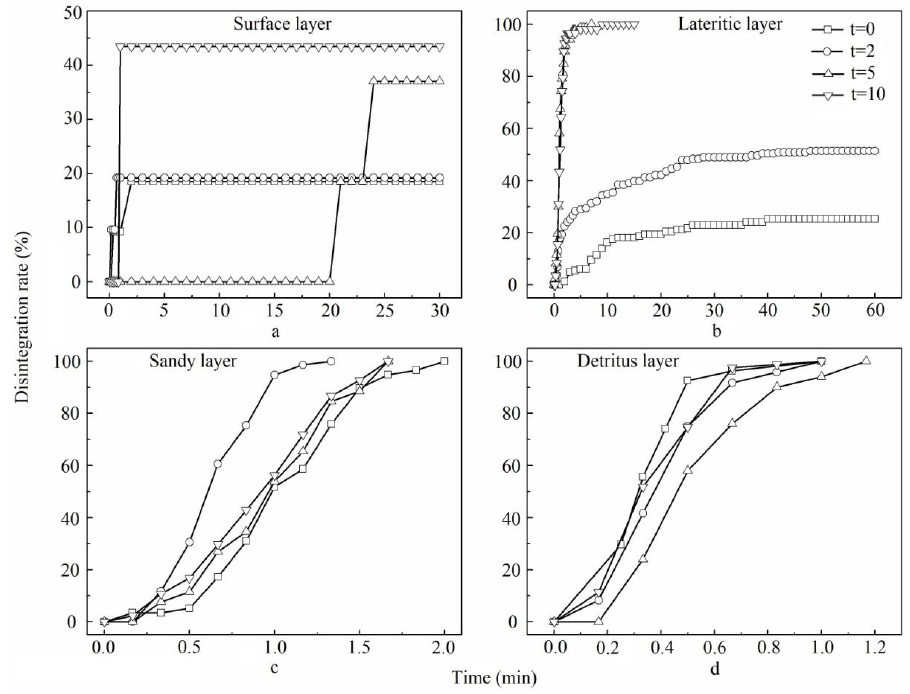
Figure 8. The disintegration process of experimental soils under W-D cycles. ( a – d ) represent the disintegration process of experimental soils of surface layer, lateritic layer, sandy layer and detritus layer, respectively.